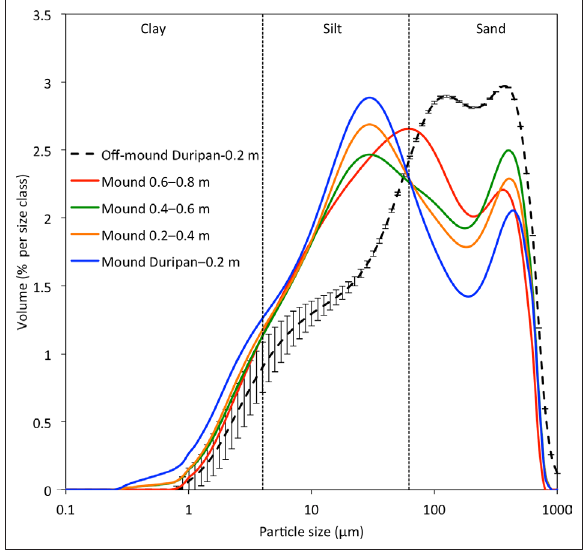
The variation in soil particle size between sieved (<1 mm) soil from on- and off-mound sites and with elevation above the duripan layer within mounds. The values represent the average for each particle size fraction ( n =5). The error bars for the off-mound soil represent standard error. Error bars were not shown for the on-mound for visual clarity.